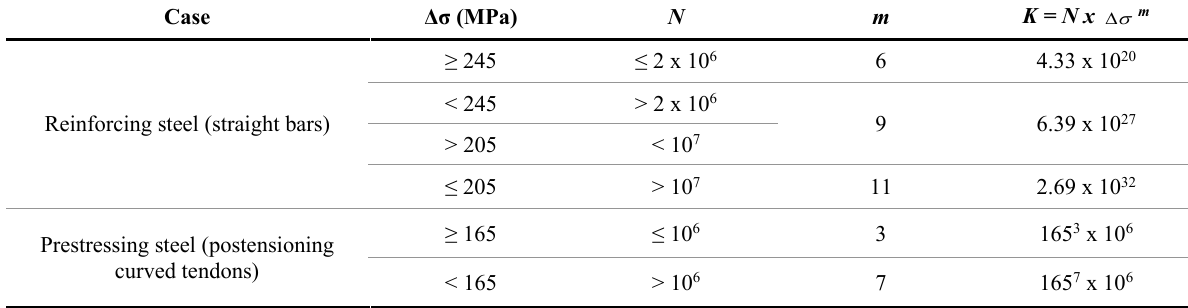
Table 2. Parameters of S-N curves for a 50% confidence level (adapted from Crespo-Minguillón and Casas [6]). Case Δσ (MPa) N m K = N x σ∆ m ≥ 245 ≤ 2 x 10 6 6 4.33 x 10 20 < 245 > 2 x 10 6 Reinforcing steel (straight bars)